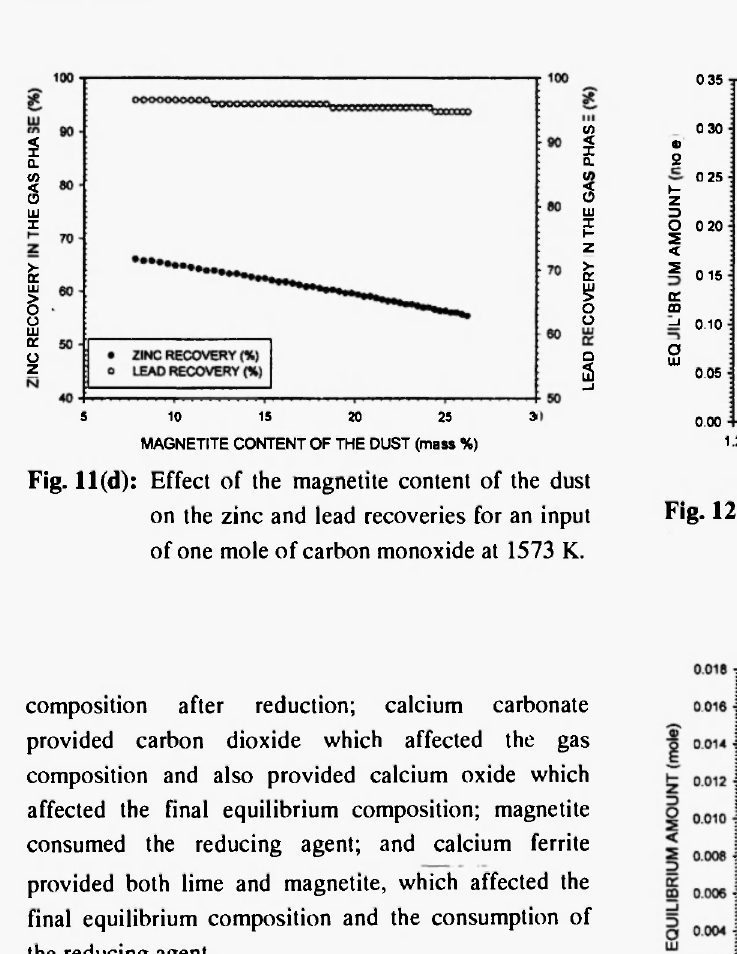
Fig. 12(a): Effect of the input partial pressure of carbon monoxide on the equilibrium amounts of the zinc-containing species at 1273 K.